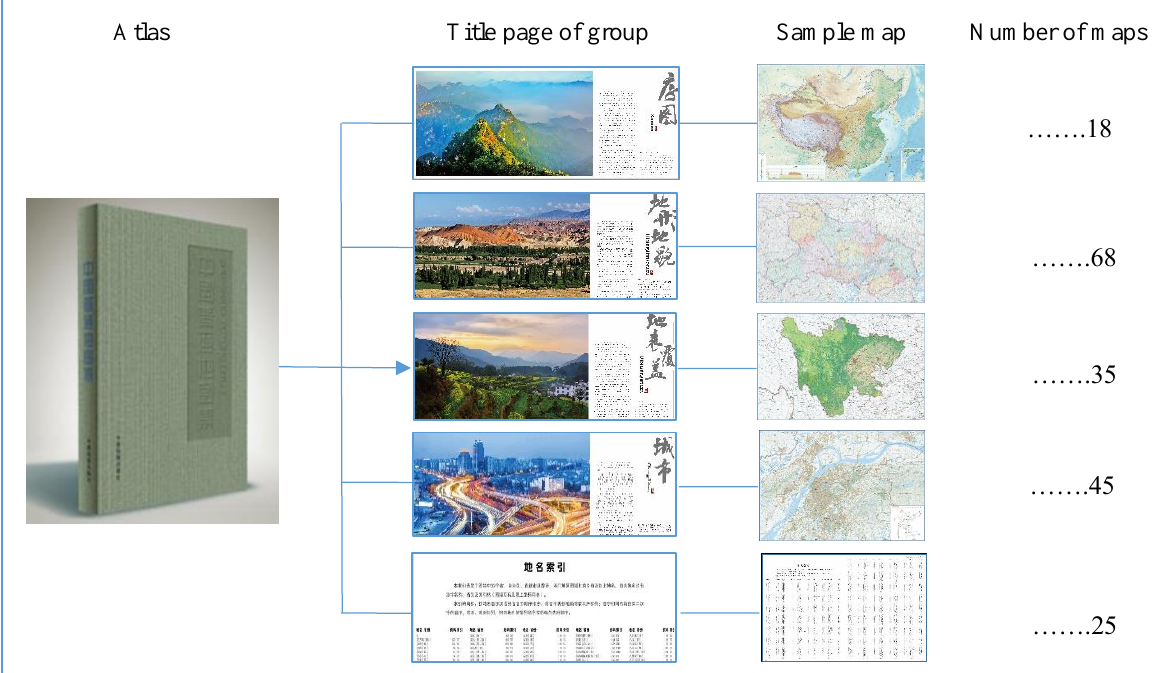
Figure 2. The sample structure of the National Fundamental Geographic Atlas of